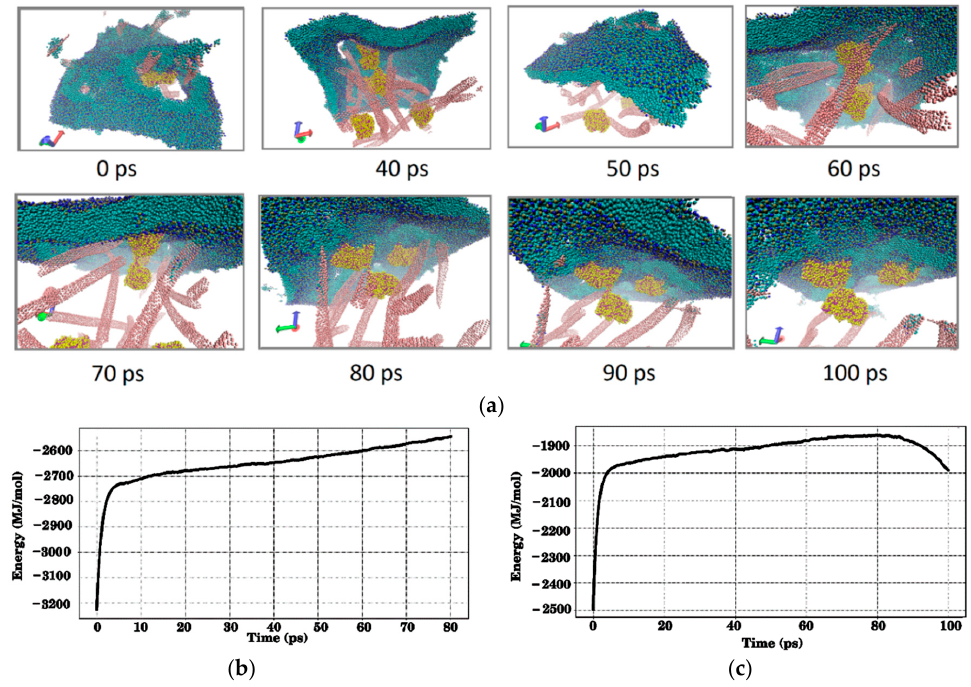
Figure 6. The interaction of the membrane with the SWCNT-albumin protein matrix: ( a ) Snapshots of the process of detachment of the membrane from the surface of the matrix; ( b ) a plot of change in the energy of the matrix + membrane system when the membrane falls on the matrix; ( c ) a plot of change in the energy of the matrix + membrane system when the membrane detaches from the matrix and moves away from it (SWCNTs are marked in pink, albumin molecules are marked in yellow and red, and the membrane is marked green and blue).